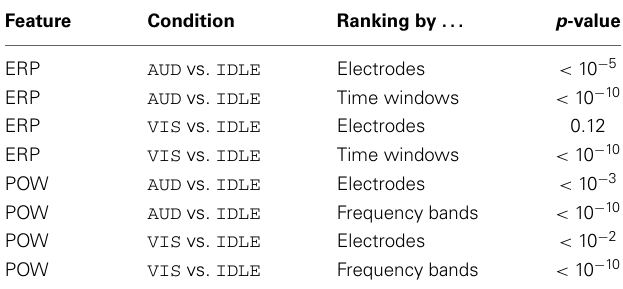
Table 7 | Resulting p -values for Friedman tests to investigate whether the calculated average feature rankings are statistically